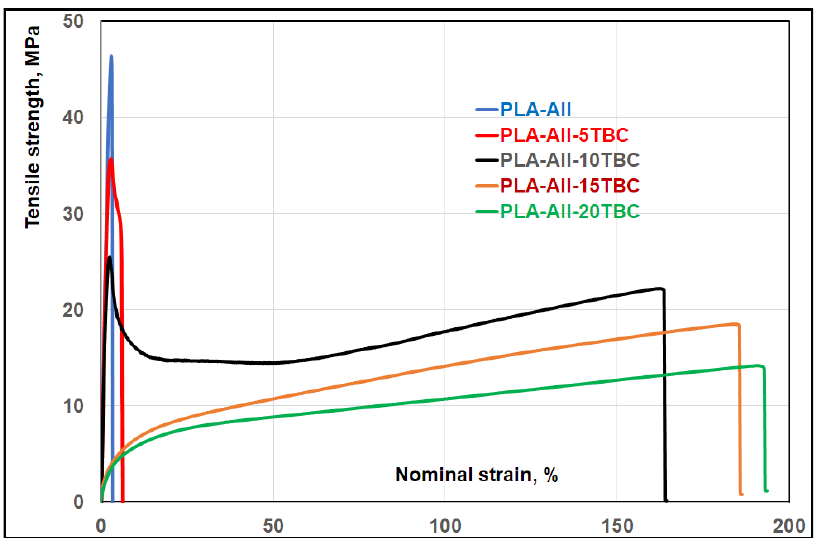
Figure 9. Typical tensile strength/strain curves of PLA–AII composites with 0–20% TBC.